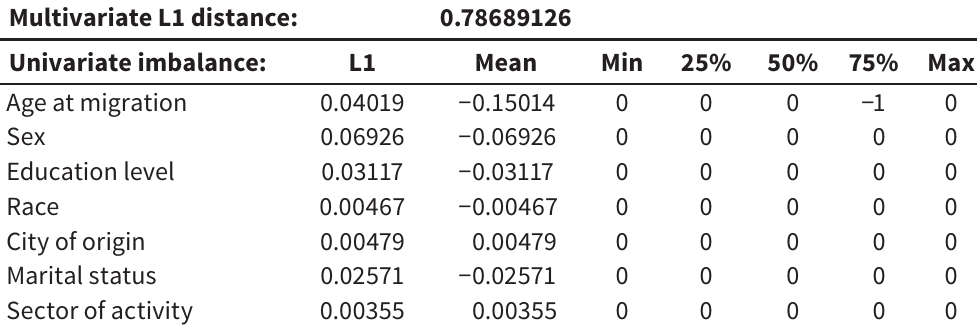
Balancing statistics after matching Multivariate L1